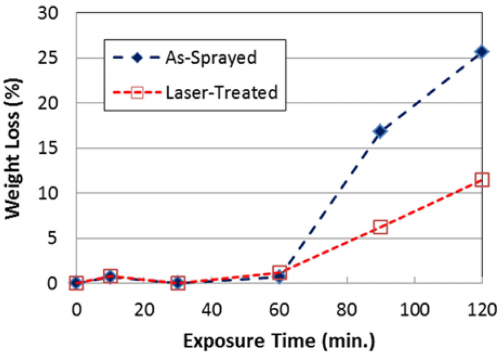
Figure 2. Oxidation behaviors of FeCrAl plasma thermal spray-coated TZM alloys before and after the laser surface